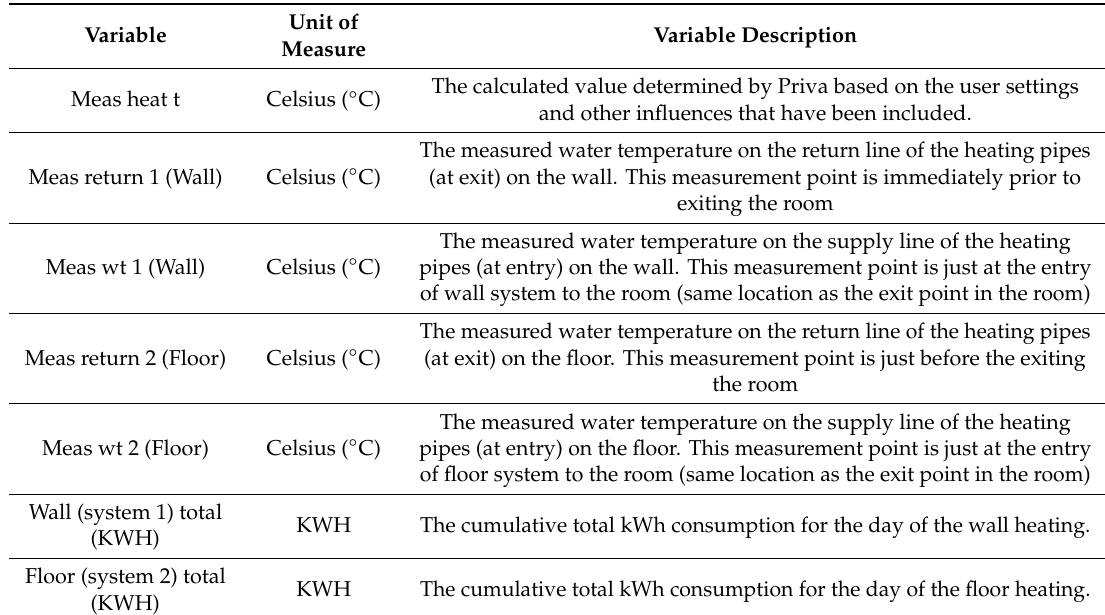
Table A2. Water Heating, Data collection Period from 30 / August / 2017 to 5 / May / 2018 with two heating networks: Return 1 and Return 2.